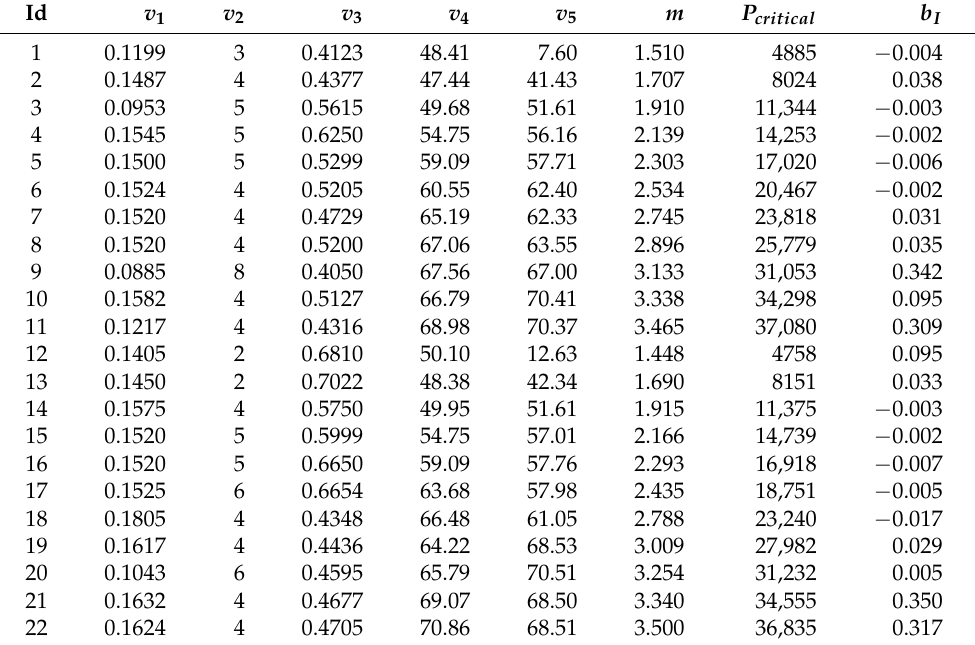
Table 10. Design values obtained from the analysis of the inverse